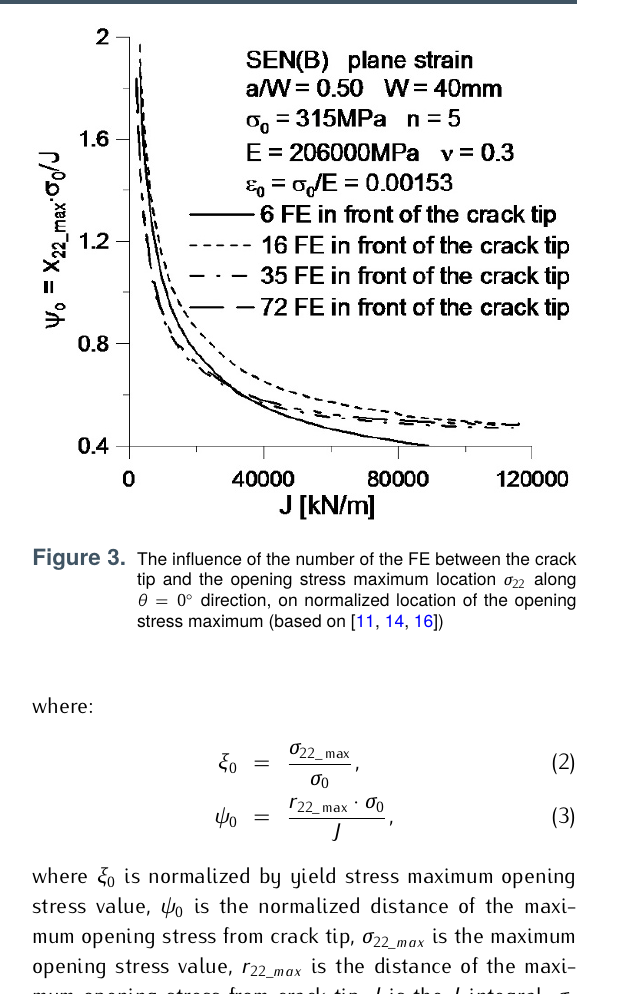
the size of the crack tip radius, the finite element size and mesh density. These same problems are encountered with the numerical designation of the J -integral, when the assumption of large deformation was done. This problem was discussed by [7, 10, 12,